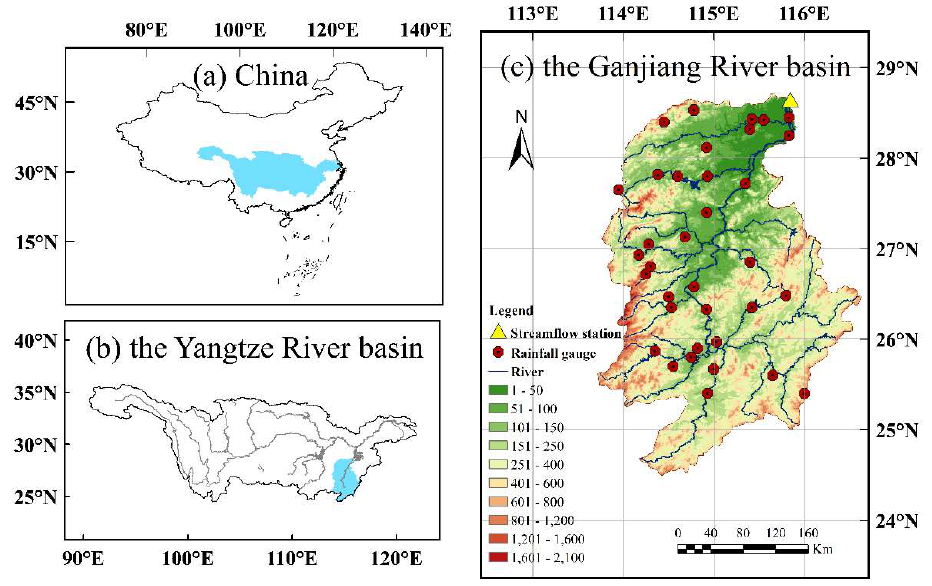
Figure 1. Locations of the study area and the related hydro-meteorological stations.